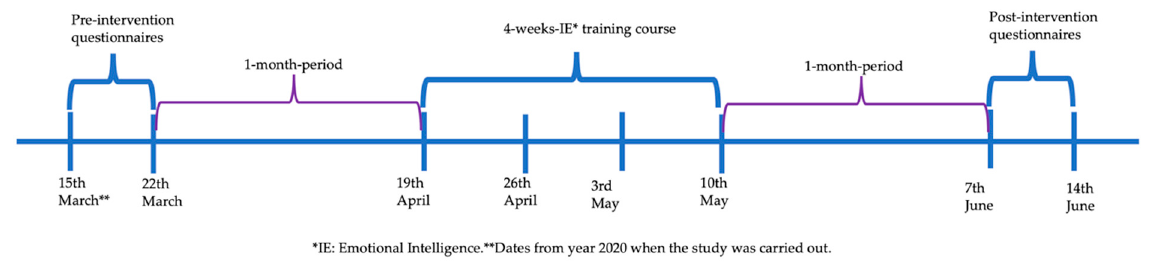
Figure 1. Figure 1. Timeline.